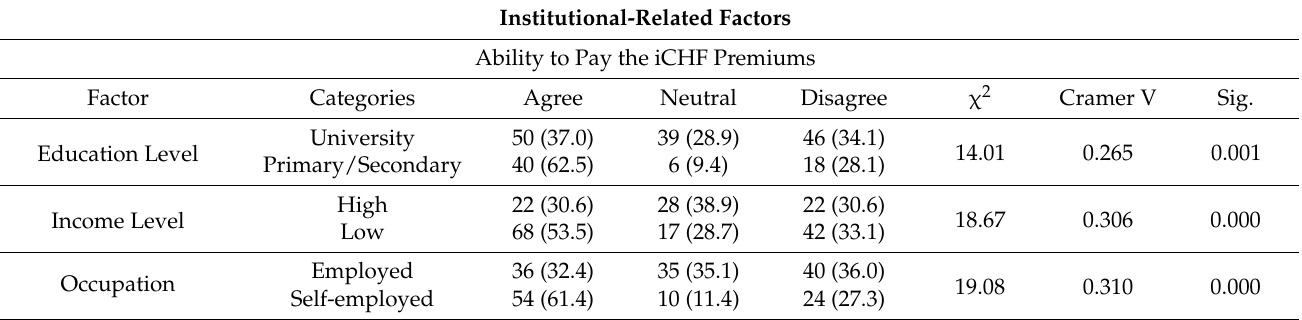
Table 4. Institution-related factors that affect the iCHF, according to healthcare providers and community